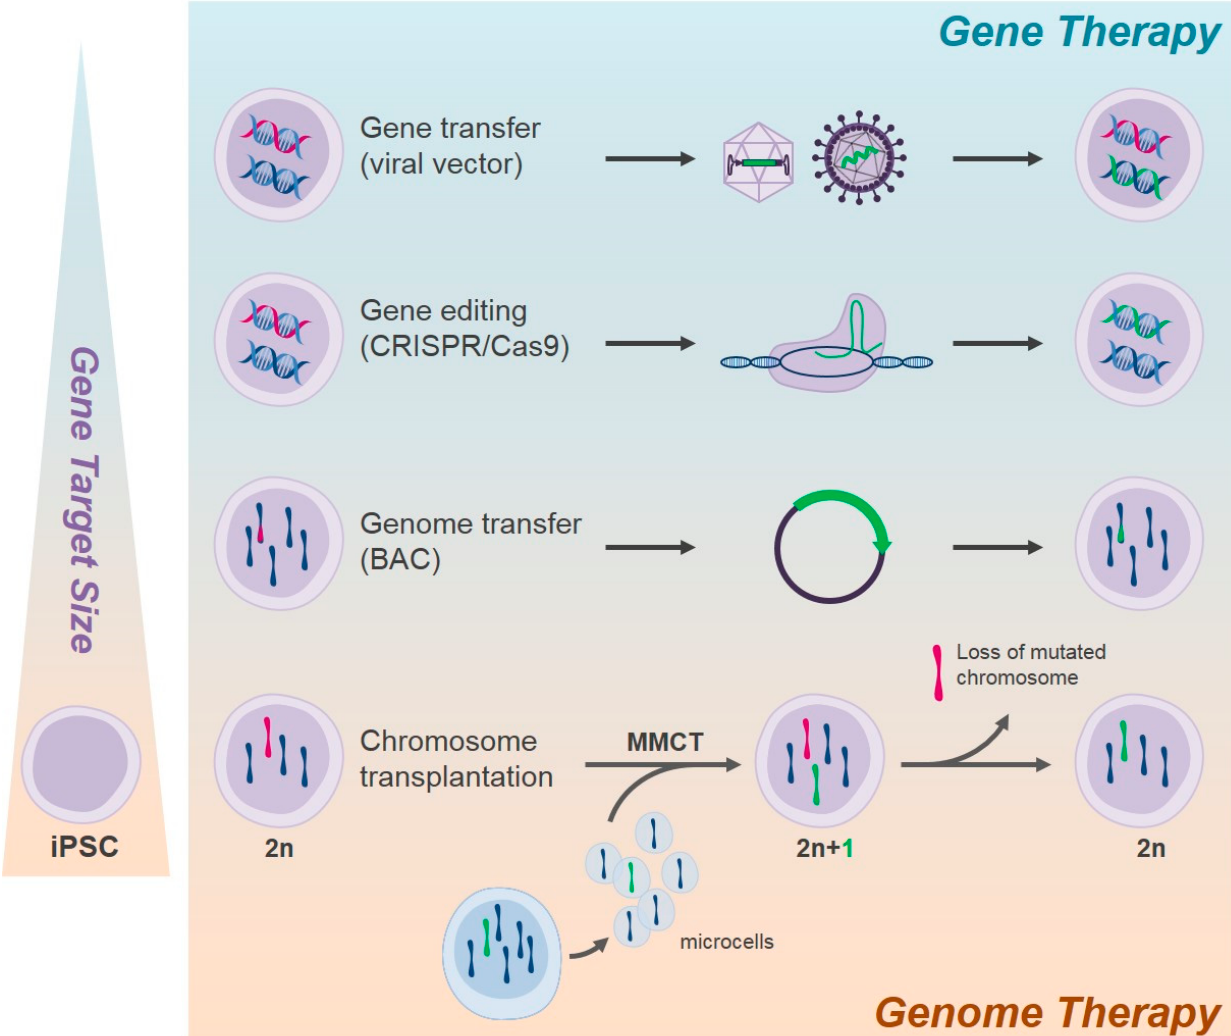
Figure 1. Gene/genome therapy options for the cure of hereditary blood disorders based on gene target size. With gene transfer WT form of the disease gene is added in the genome of the recipient cells; with gene editing the mutated gene is corrected; with BAC-mediated genome transfer the mutated gene including upstream regulatory sequences and intronic regions is substituted with homologous recombination; with chromosome transplantation the entire chromosome containing the altered gene(s) is replaced with a WT chromosome. MMCT, microcell-mediated chromosome transfer. Viral-mediated gene transfer or CRISPR/Cas9-mediated gene editing might be ideal as GT platforms for small-size gene defects, while BAC-mediated or CT-mediated